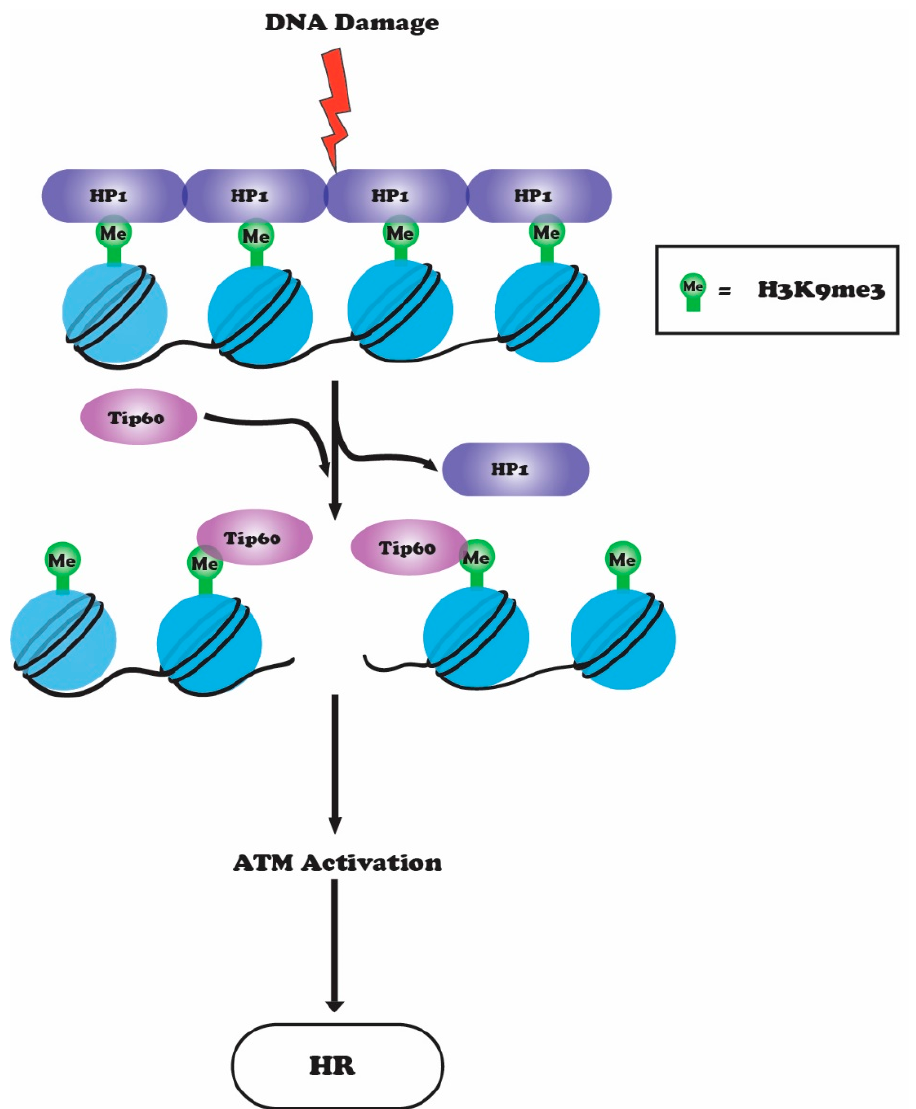
Figure 4. In response to DNA damage, HP1 is displaced from the H3K9me3 site allowing TIP60 to interact with H3K9me3 via its chromodomain. The interaction of TIP60 with H3K9me3 stimulates its HAT activity, which leads to acetylation of ATM and subsequent activation of its kinase activity, downstream ATM signaling, and HR-mediated repair.